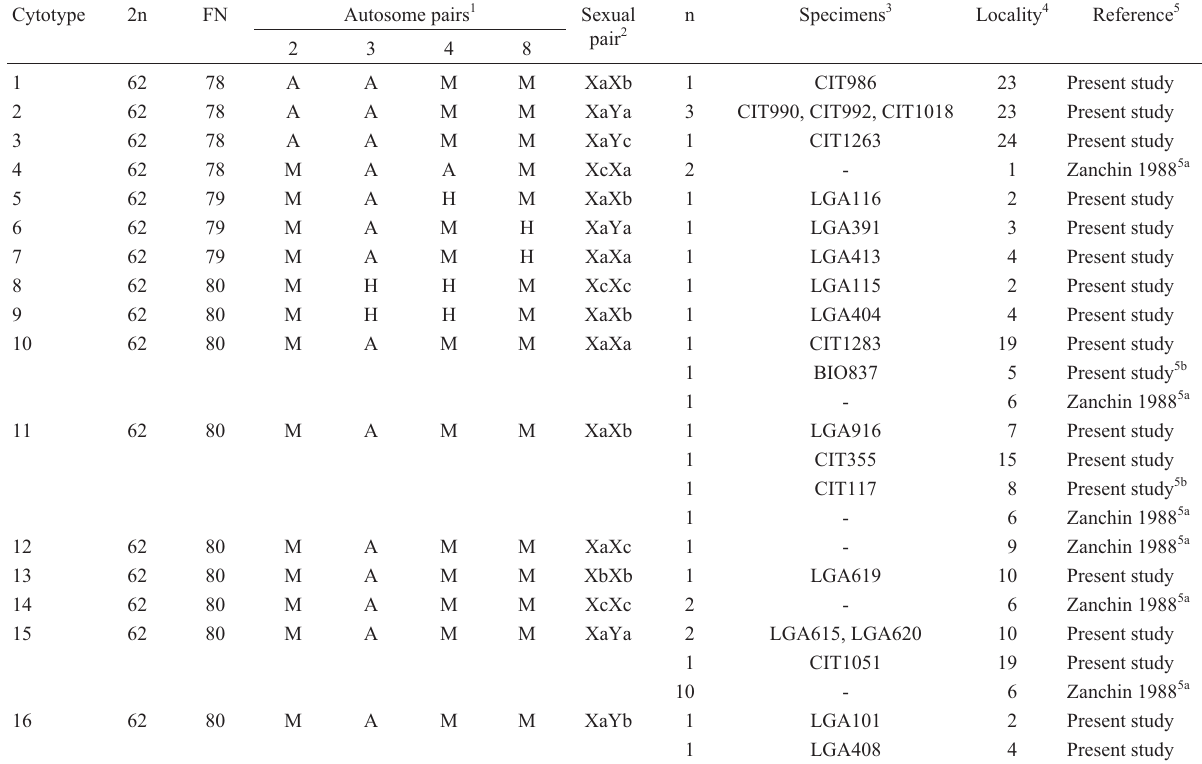
Table 1 - Cytotypes of Oligoryzomys nigripes with 2n = 62 and FN = 78-82. Cytotype